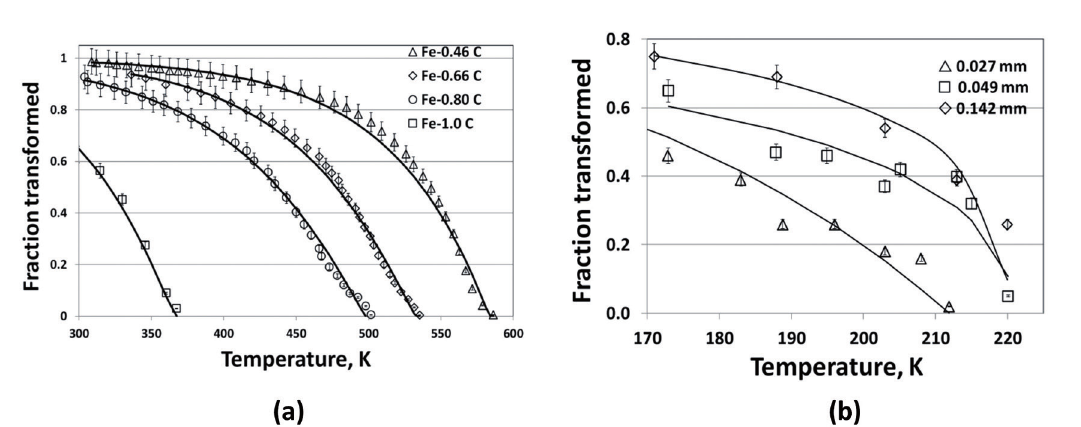
Figure 5: Time independent transformations (See Table 2.) - (a) Fe-0.46wt%C, Fe-0.66wt%C steel, Fe-0.80wt%C (0.130 mm grain intercept) 9,30 ; (b) Fe-31wt%Ni-0.02wt%C (0.027-0.142 mm grain intercept) 31